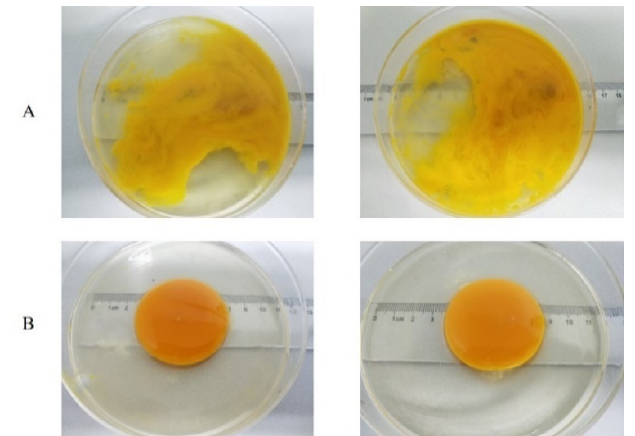
Figure 4. Comparison of albumen and yolk morphologies between non-irradiated eggs ( A ) and BL-irradiated eggs ( B ) after 5 weeks.